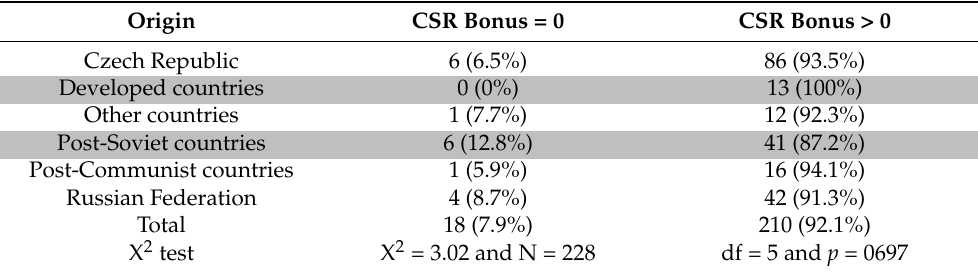
Table 3. Contingency table H 0 origin—the frequency of no CSR bonus payers is similar (but not the same) for students of different